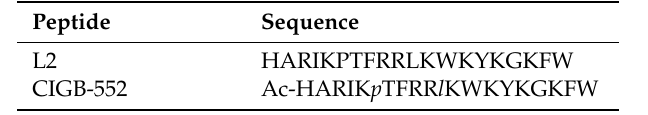
Table 2. L2 and CIGB-552 peptide sequence.